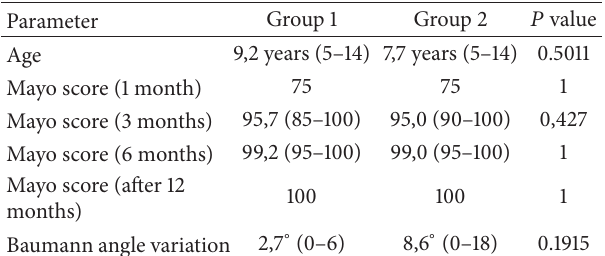
Table 3: Summary of results: mean age, MEP scores, and Baumann’s angle